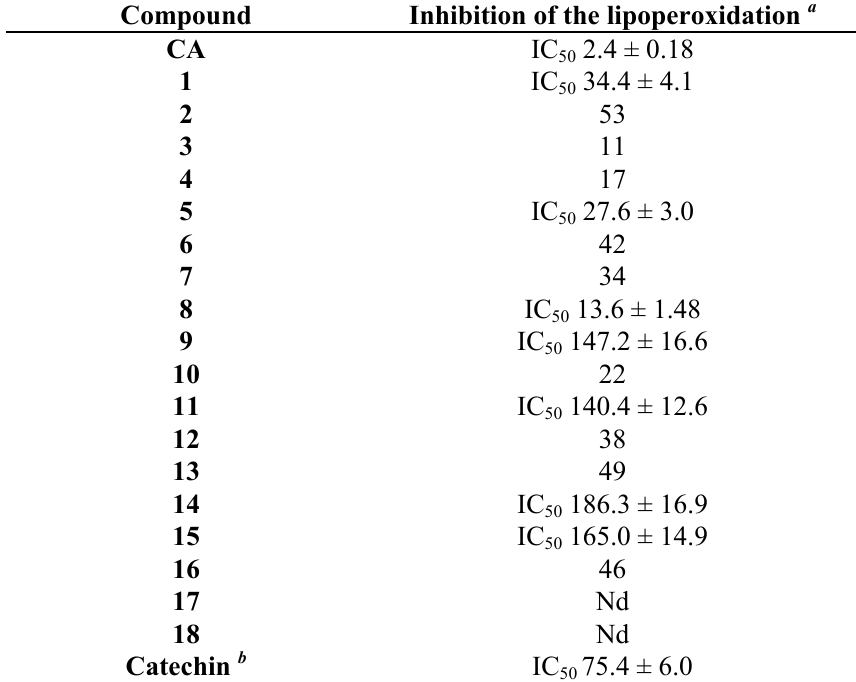
Table 3. Effect of CA and derivatives 1 – 18 on the inhibition of the lipoperoxidation